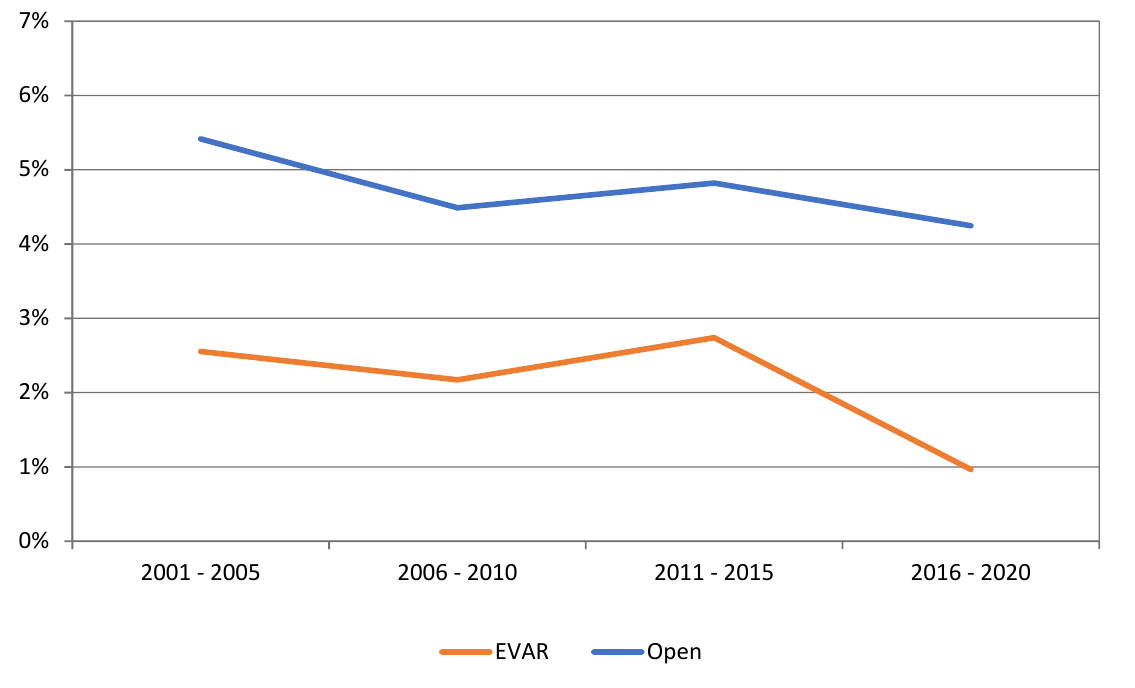
Figure 8. Intact AAA 30-day mortality by repair type.